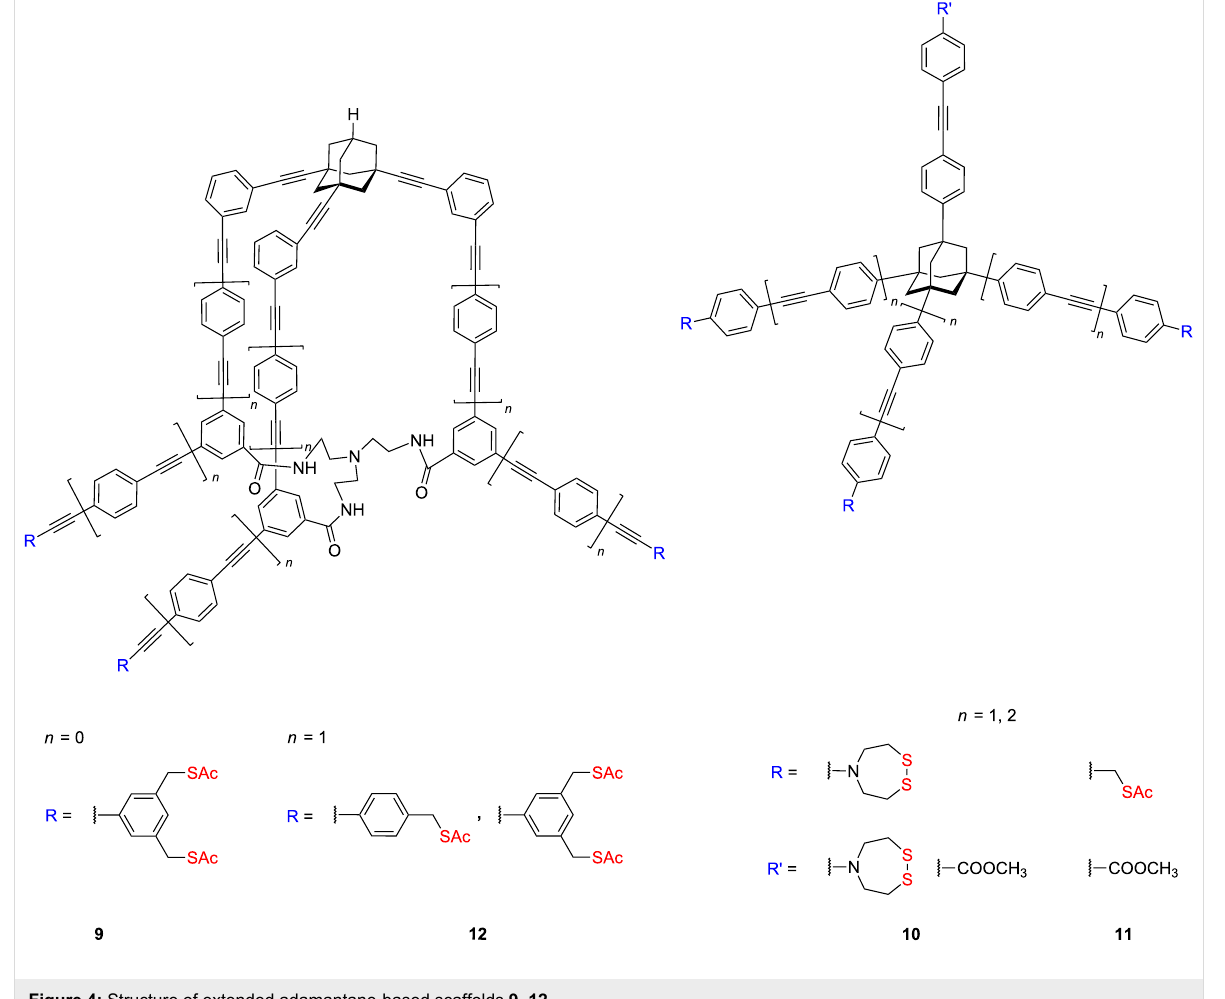
Figure 4: Structure of extended adamantane-based scaffolds 9–12